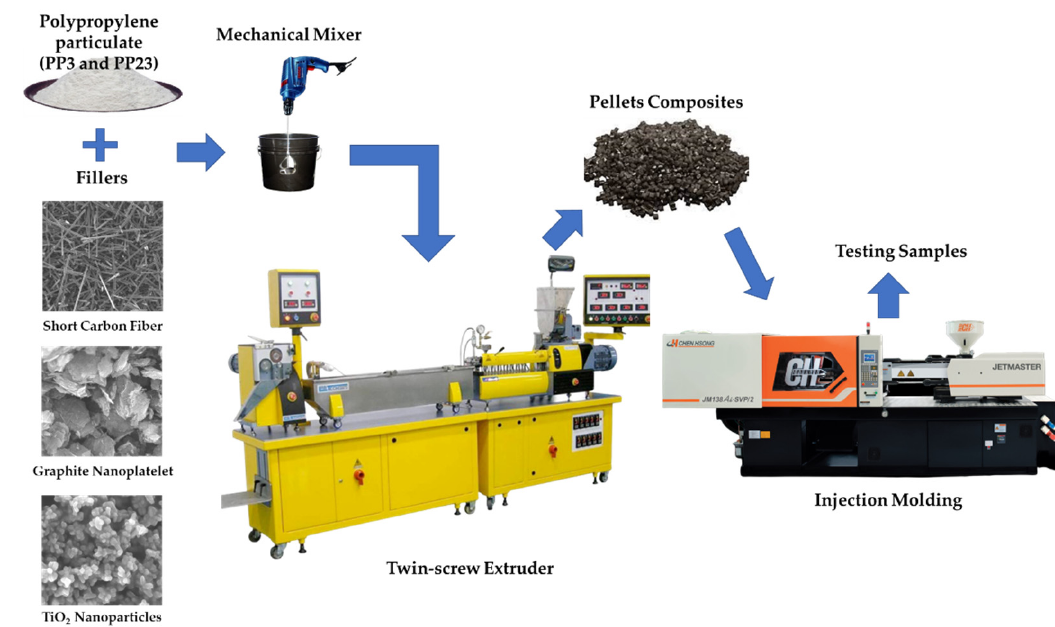
Figure 2. Processing steps schematic of the composites.